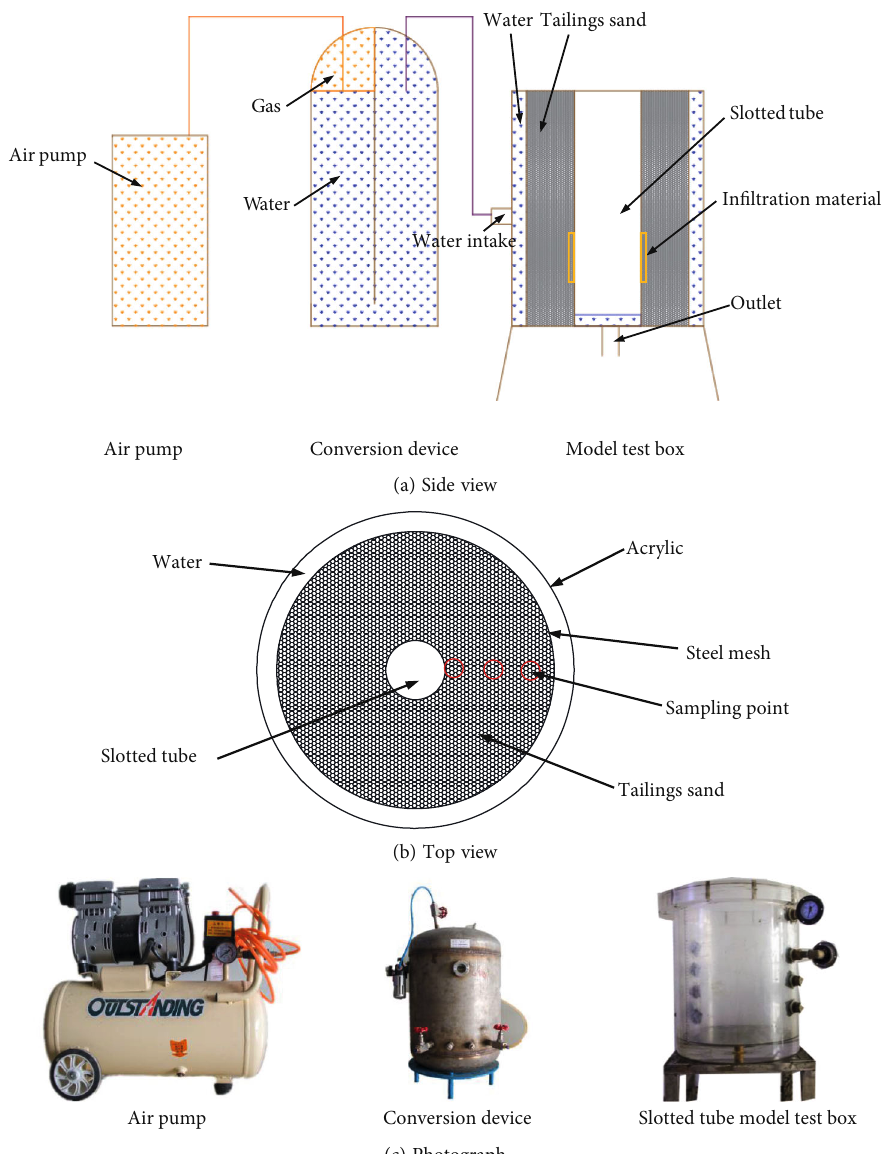
Figure 4: Experimental system and devices.